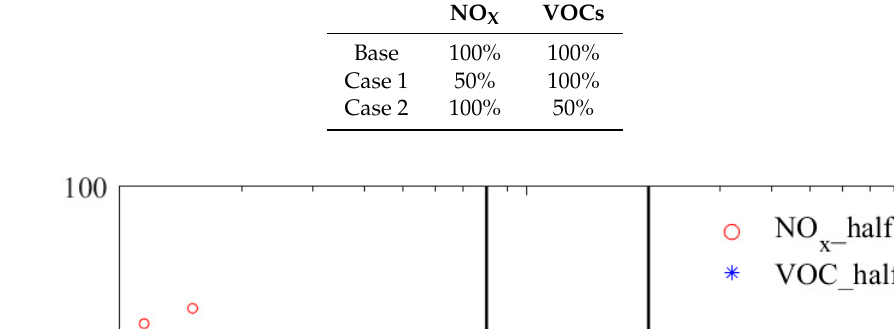
Table 2. Sensitivity experiment design scheme—Base: baseline emission source; Case 1: 50% reduction in the NOx emission source; Case 2: 50% reduction in the VOC emission source.